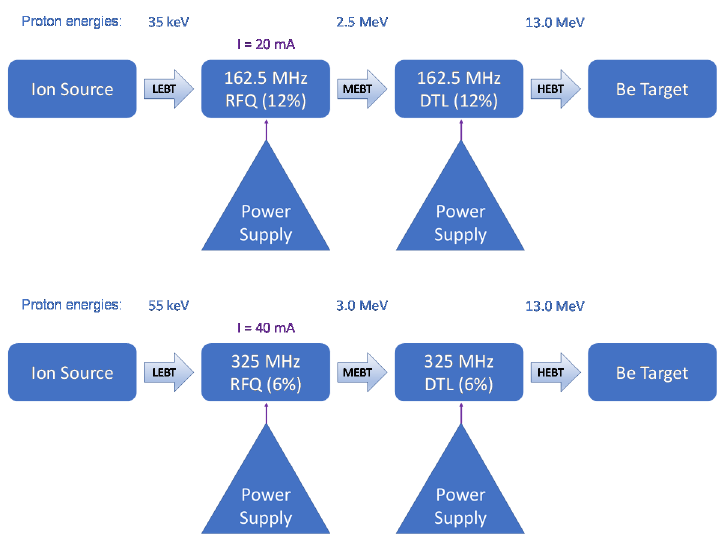
Figure 1. Schematic diagram of the ABNS layout: ( Upper ) a 162.5 MHz design option, ( Lower ) a 325 MHz design option.